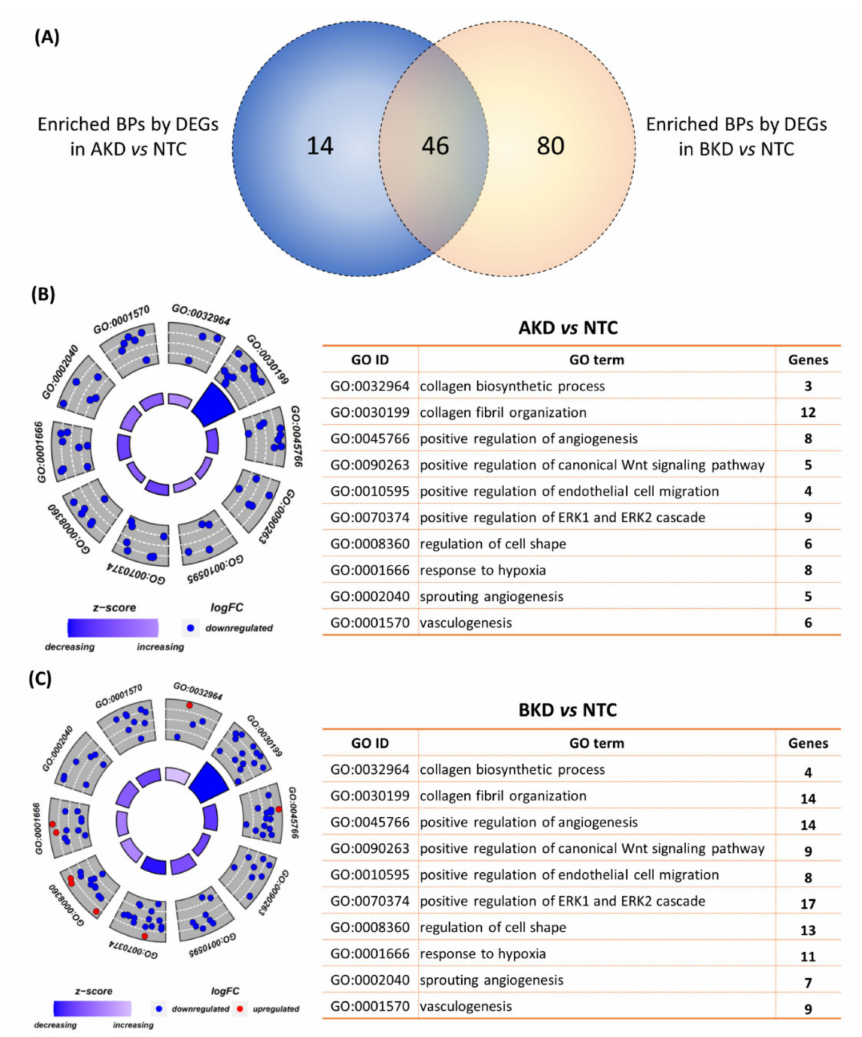
Figure 3. GO enrichment analysis for biological processes of the DEGs in AKD vs. NTC and BKD vs. NTC. ( A ) Venn plot of the BPs significantly enriched by the DEGs in AKD vs. NTC and BKD vs. NTC. The figure also shows 10 BPs related to placental or fetal growth significantly enriched by the DEGs in ( B ) AKD vs. NTC and ( C ) BKD vs. NTC. The blue dots indicate downregulated genes, the red dots indicate upregulated genes, and the white dotted line indicates the partition of logFC from low to high level. A complete list of BPs significantly enriched by the DEGs in AKD and BKD TE is provided in Tables S2 and